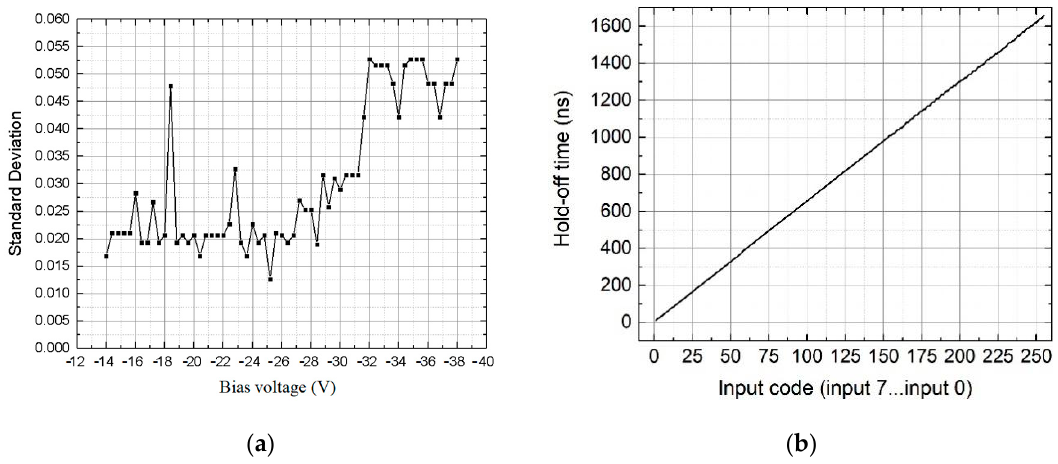
Figure 5. ( a ) The bias voltage boost circuit’s output voltage with the voltage set on computer; ( b ) External input codes versus hold-off time.